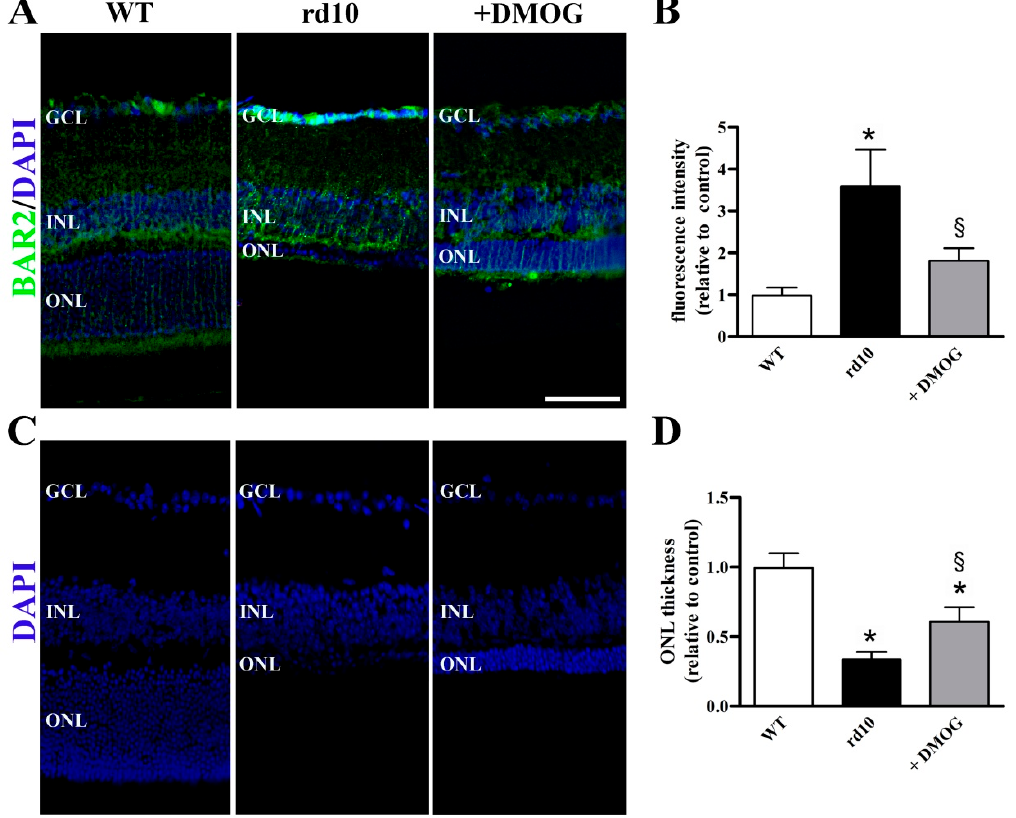
Figure 6. BAR2 localization in retinal sections from untreated WT and rd10 mice either untreated or treated with DMOG. ( A ) Images of retinal sections immunolabeled with antibodies against BAR2 (green) and stained with 4 ′ ,6-diamidino-2-phenylindole (DAPI; blue). ( B ) Quantitative analysis of fluorescence intensity. ( C ) Images of retinal sections stained with DAPI. ( D ) Quantitative analysis of the ONL thickness. DMOG decreased BAR2 immunoreactivity and increased the ONL thickness in rd10 mice. GCL, ganglion cell layer; INL, inner nuclear layer, ONL, outer nuclear layer. Scale bar, 50 µm ( n = 5 retinas per group). * p < 0.001 versus WT; § p < 0.01 versus untreated rd10 (one-way ANOVA followed by the Tukey post-hoc test).